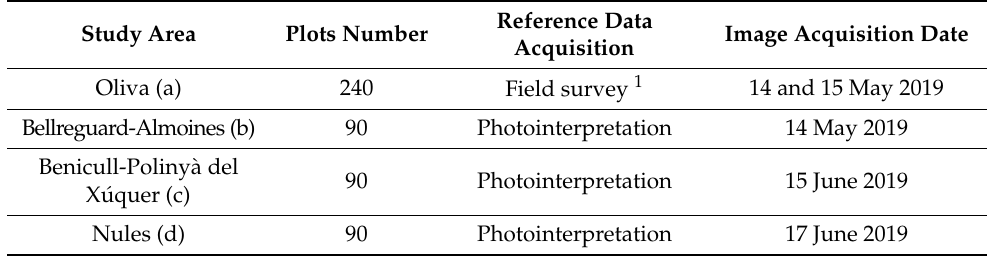
Table 1. Reference data and image acquisition date in each study area. Study Area Plots